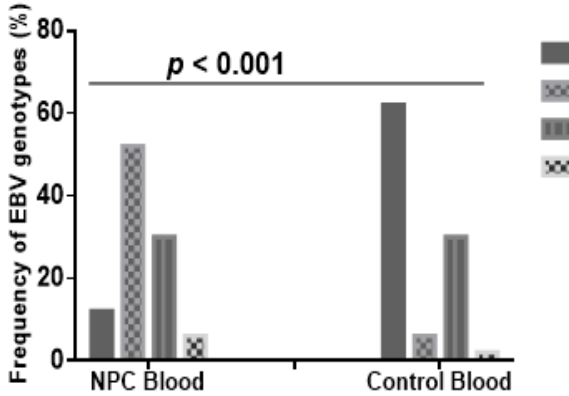
Figure 2. Frequency distribution of EBV genotypes in cases and control samples. Frequency of EBV genotype 1 was significantly higher in control subjects than cases, whereas frequency of EBV genotype 2 was significantly higher in cases than controls, when comparison was done using Chi-squared test of independence for contingency table ( p < 0.001).